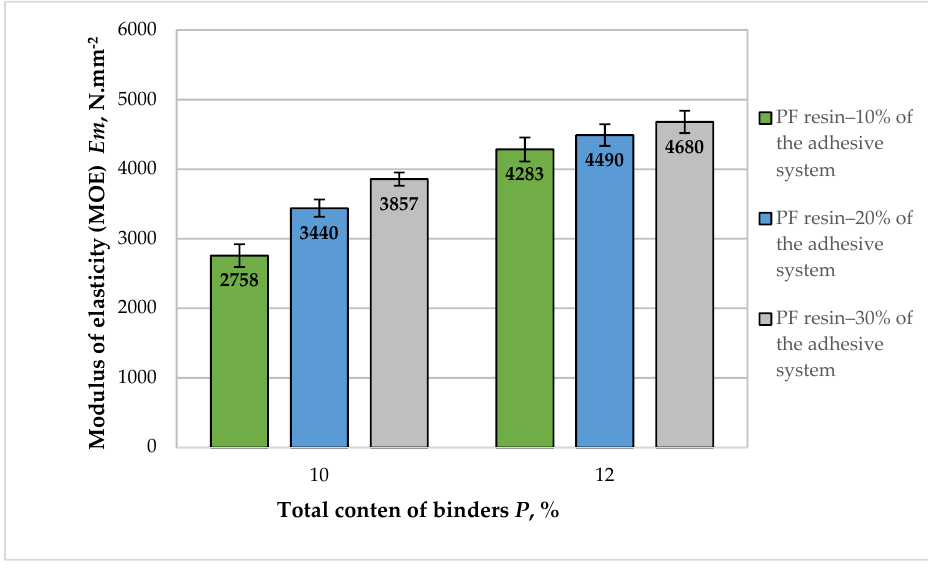
Figure 3. Modulus of elasticity (MOE) of fiberboard panels bonded with HL and PF resin.